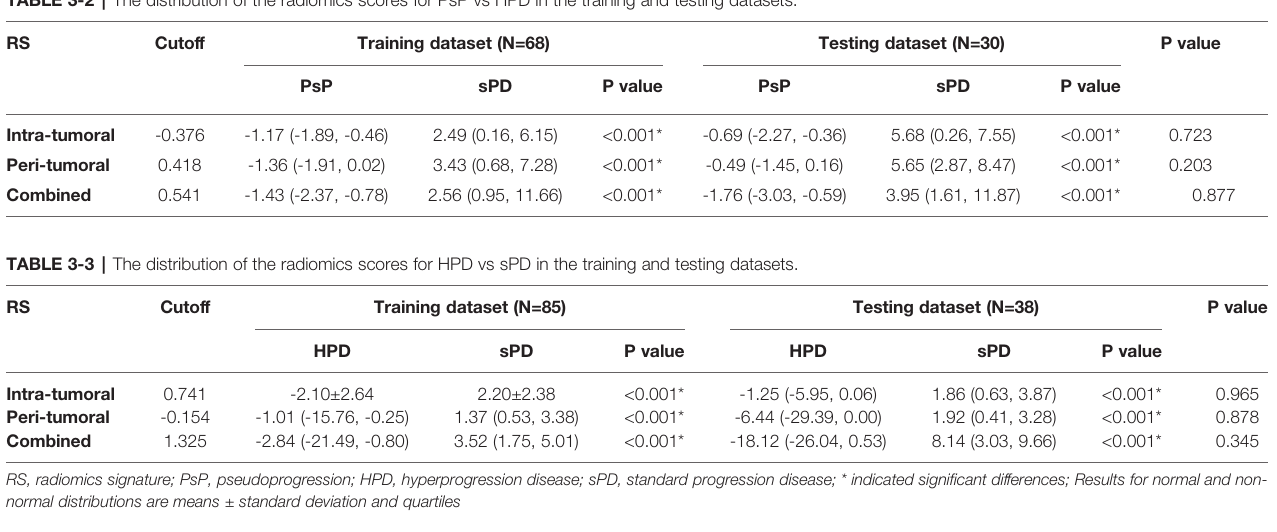
The optimal cutoff values in the intra-, peri-tumoral, and combined model are displayed in Table 3-2 . The calibration curve and decision curve are shown in Figures S4 , S5 and Figures 5 , 6 .